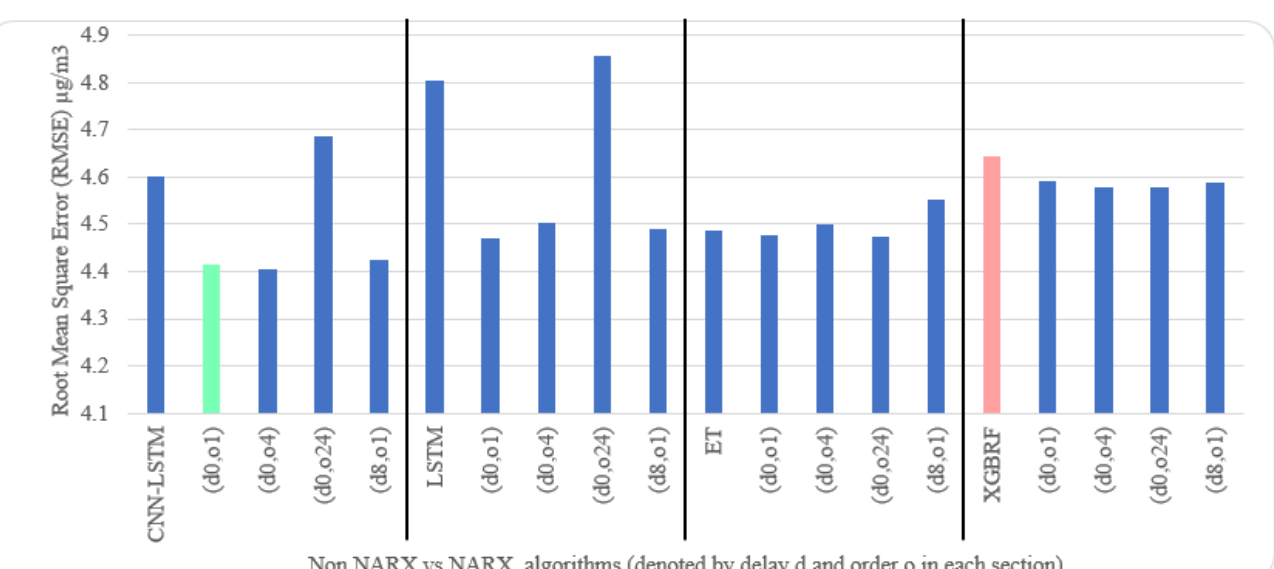
Figure 28. Evaluation results of non-NARX and NARX in terms of index of agreement for Manch- ester dataset.